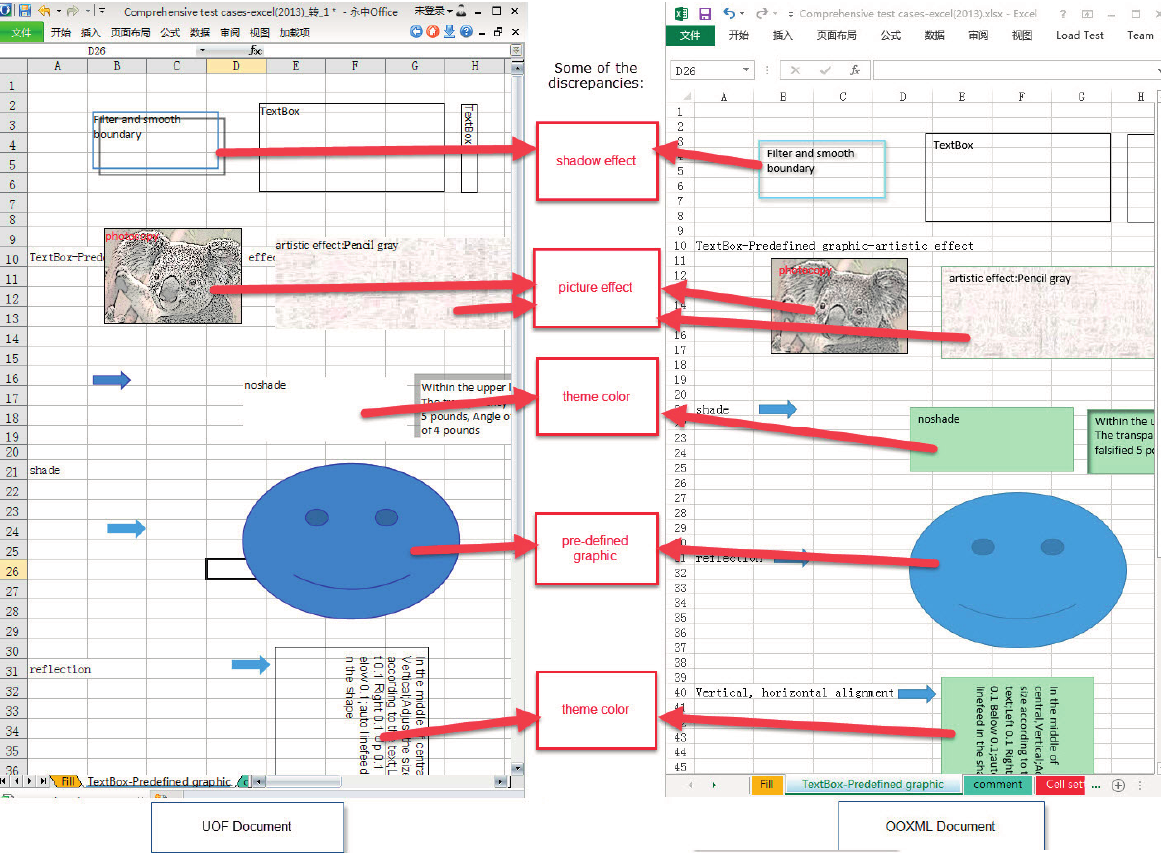
Figure 3. Spreadsheet